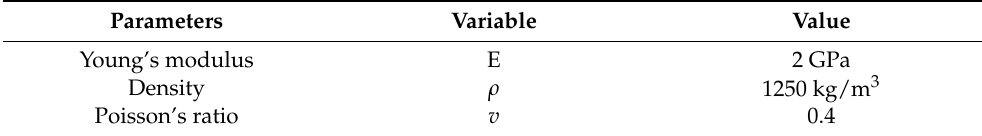
Table 2. Properties of the Epoxy